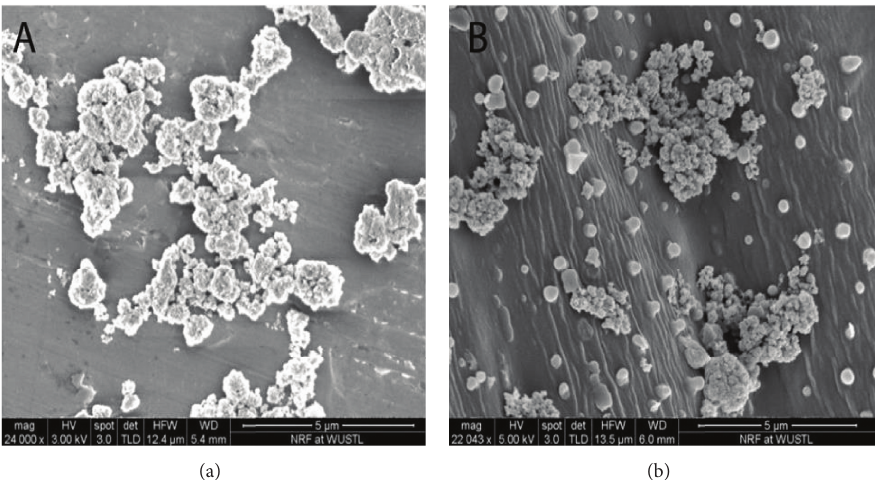
Figure 9: Scanning electron microscope images for NPs/lettuce seeds. In the aqueous phase, the SEM image shows that metal oxide NPs (TiO2 NPs 1000 mgL −1 ) (a) and (CuO NPs 1000 mgL −1 ) were adsorbed on the seed surface (b)